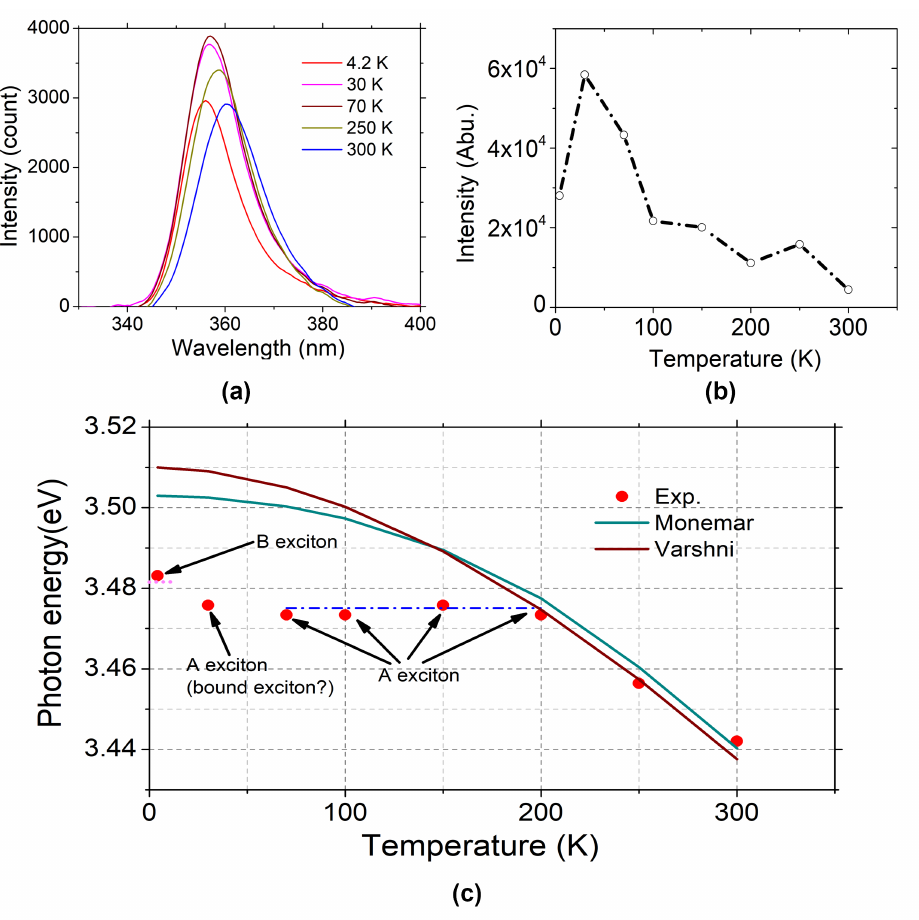
Figure 4. ( a ) EL spectra at different temperatures, V b = 5.8 V. ( b ) Light emission vs. temperature. ( c ) The comparison between the extracted photon energies and the